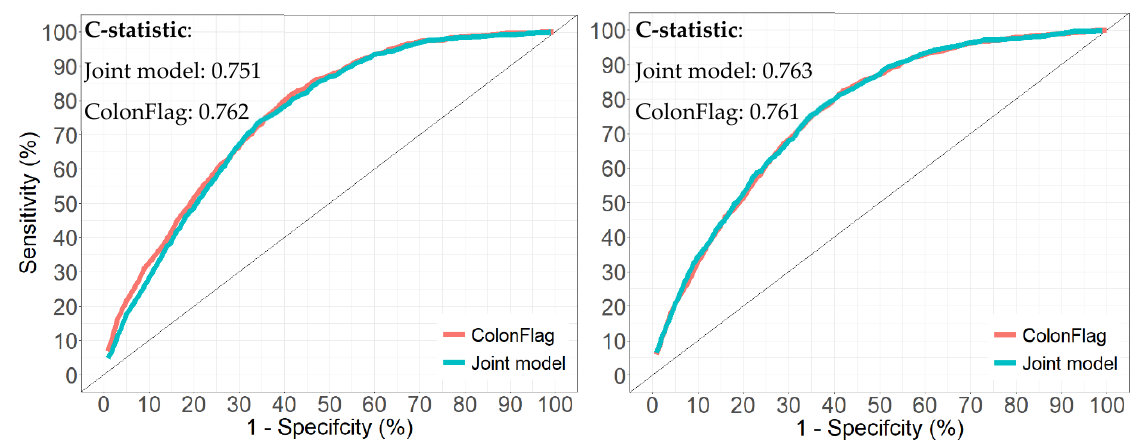
Figure 4. ROC curves for the joint models and ColonFlag for males ( left ) and females ( right ) (validation cohort).